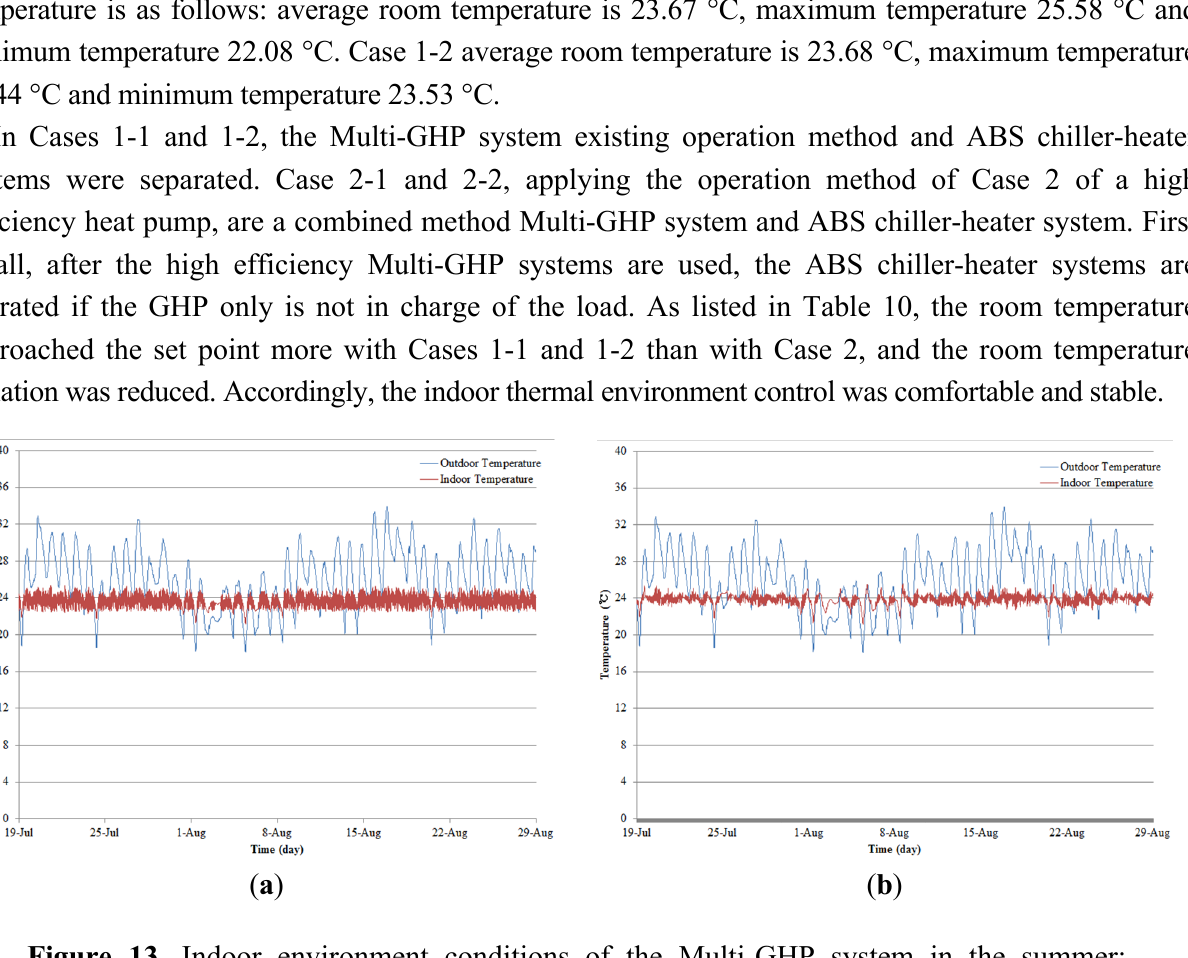
Figure 13. Indoor environment conditions of the Multi-GHP system in the summer: ( a ) existing operation condition of Multi-GHP system (Case 1-1); ( b ) sequencing operation condition of Multi-GHP system (Case 1-2).